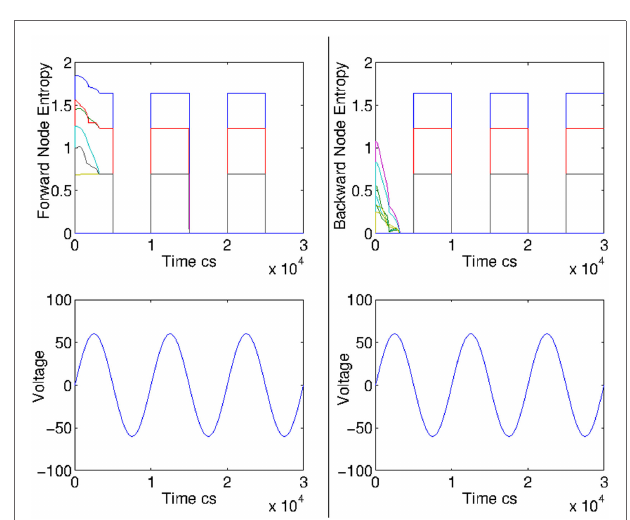
FIGURE 7 | We show the difference between the node entropy measure based on forward probability (left) and backward probability (right) in the case of AC controlled memristive circuits . If the frequency is lower than the inverse of the half thermalization time, then the entropy is zero in the negative voltage part of the generator, as the left plot shows. In this case, one has to use backward